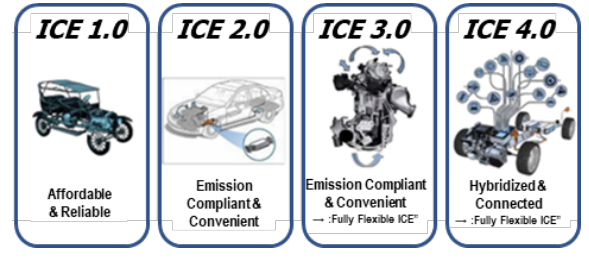
Fig. 1. Passenger car powertrain system development